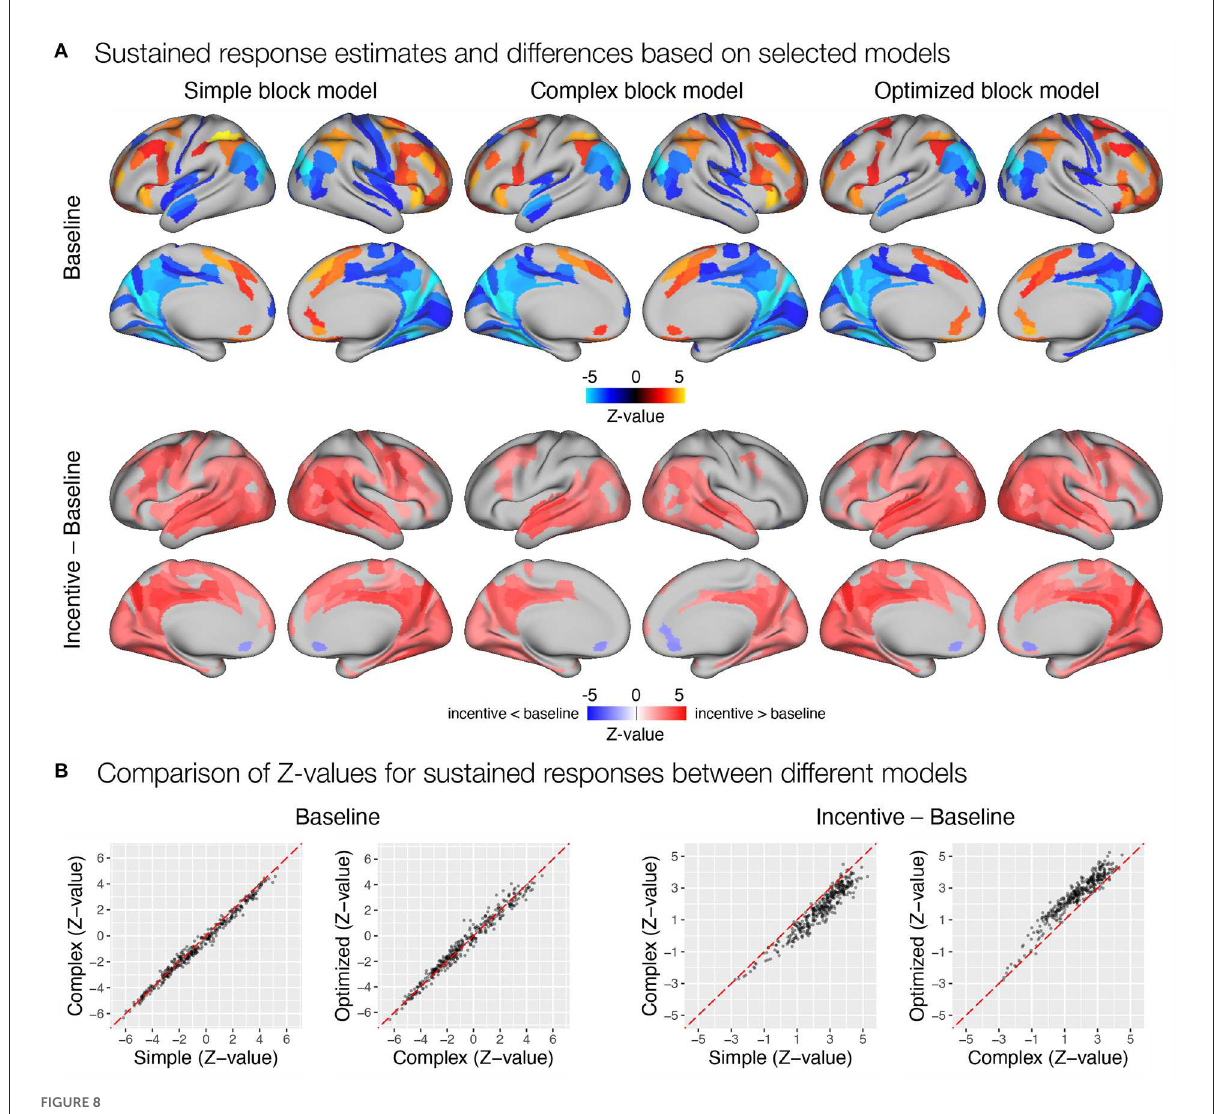
FIGURE8 Estimation of task sustained response and incentive effects using different event models in the flanker study. (A) Significant sustained whole-brain activations and deactivations in baseline condition (first row) and significant differences between sustained task response in baseline and incentive conditions (second row) are shown. (B) A comparison of Z -values obtained with different models. Each point represents a Z -value obtained for a brain parcel using the two models compared. The red diagonal presents equal